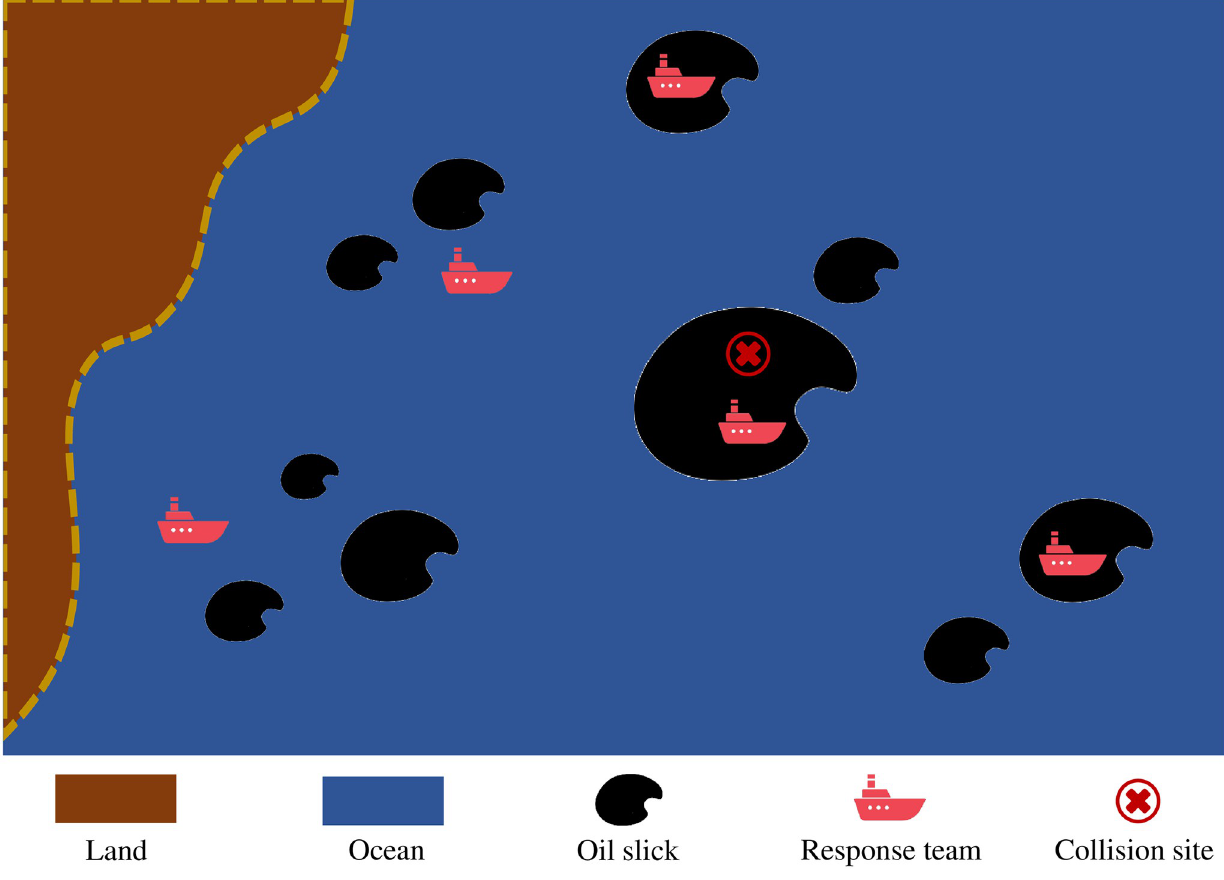
Fig 7. Illustration of the simulation